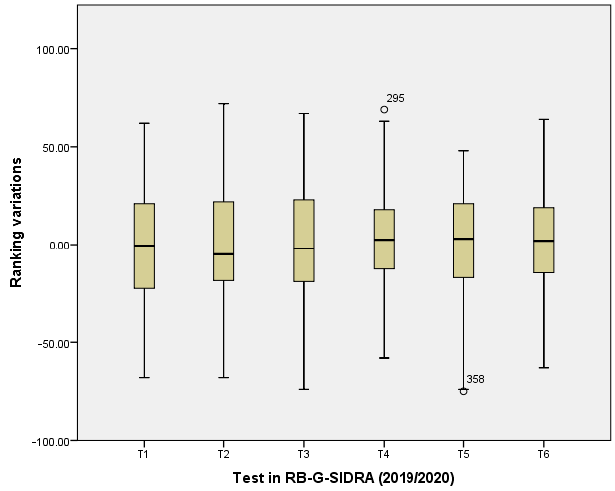
Figure 6. Box Diagram for Ranking Variations in the Academic Course 2019/2020 (RB-G-SIDRA). H5. Spearman’s rank correlation coefficients between individual and team scores for Table 4. Spearman’s Rank Correlation Coefficient Results between Individual and Team Score in RB-G-SIDRA (gamified SIDRA with ranking and badges) and R-G-SIDRA (gamified SIDRA with ranking). “Tx”: Test x; “CC”: Correlation Coef- ficient; “N”: Sample Size; “ p ”: p Value.